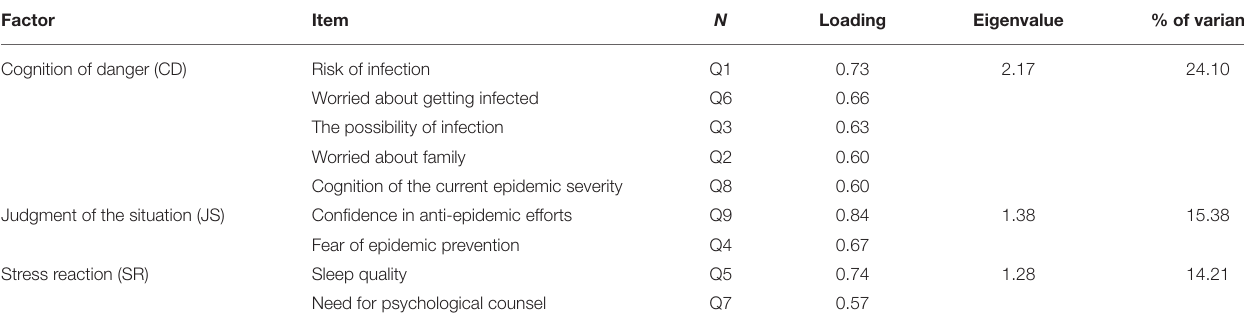
TABLE 1 | Item loadings, eigenvalues and variances of the questionnaire according to PCA. Factor Item